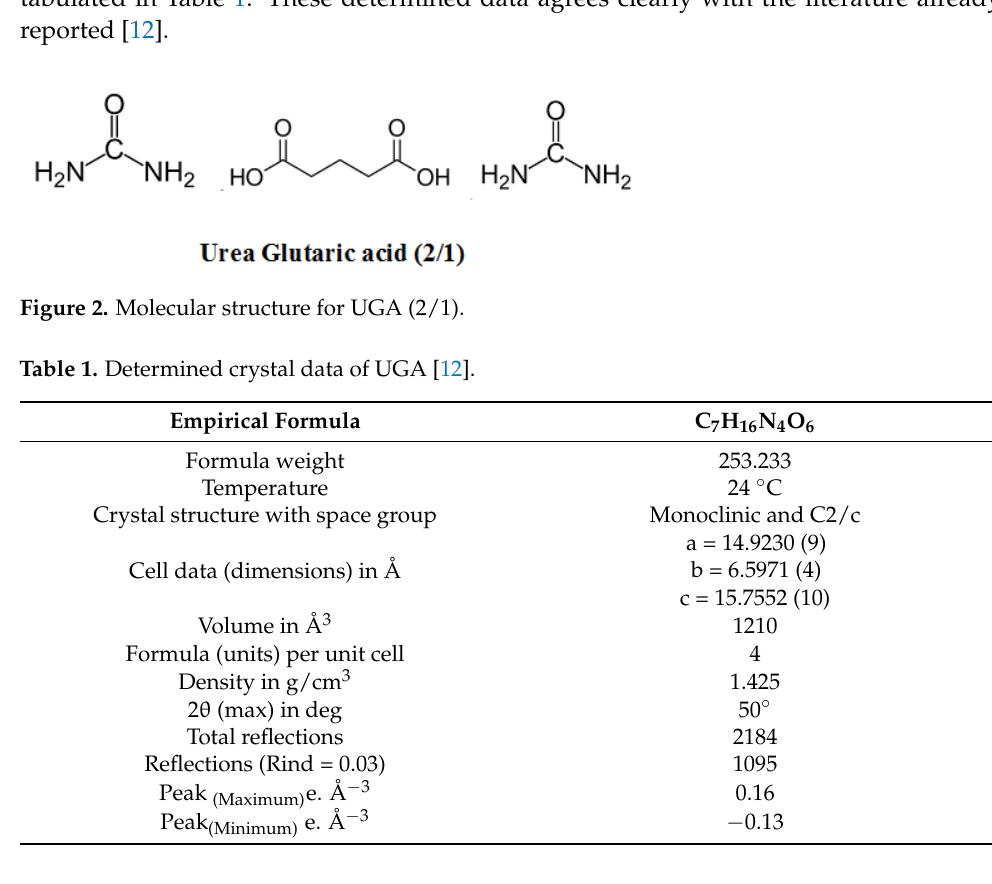
Figure 1. Solubility curve for UGA crystal with grown crystal inside.